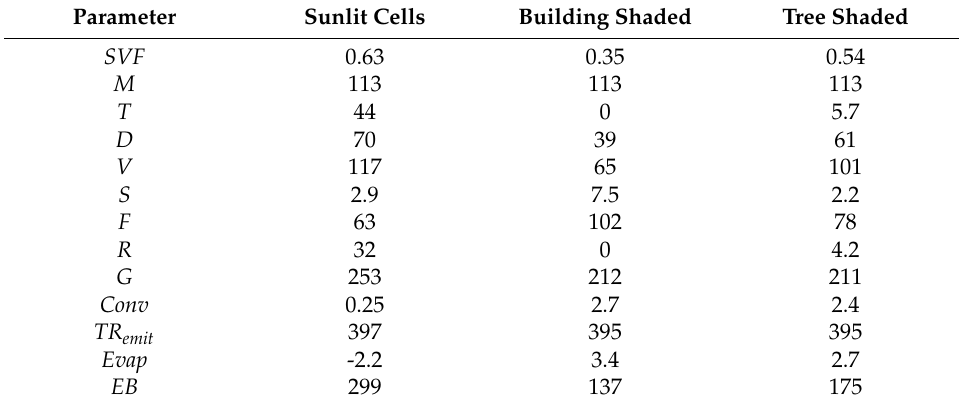
Table 3. Mean for SVF , energy components, and EB for sunlit, building- and tree-shaded cells at 1 p.m. on street.